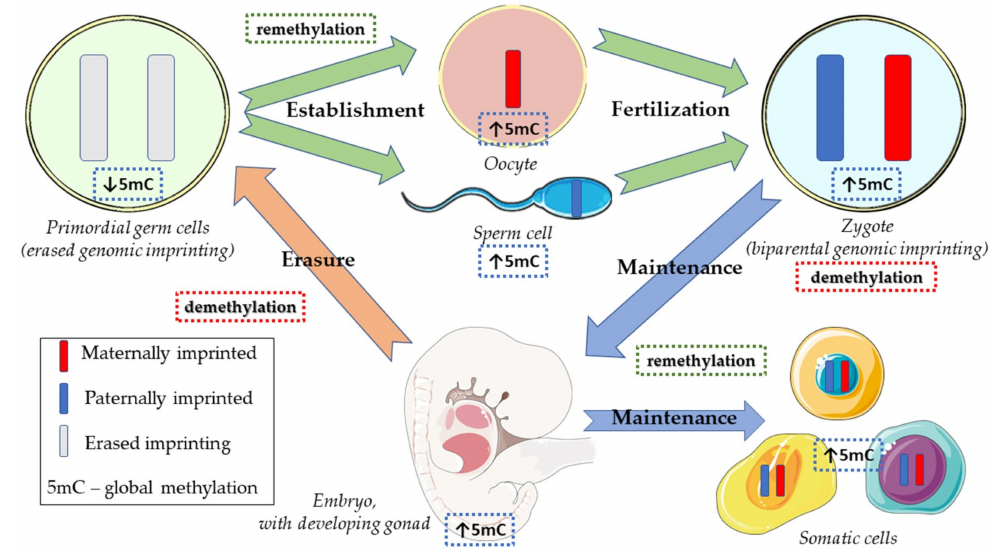
Figure 1. Cycle of genomic imprinting and global